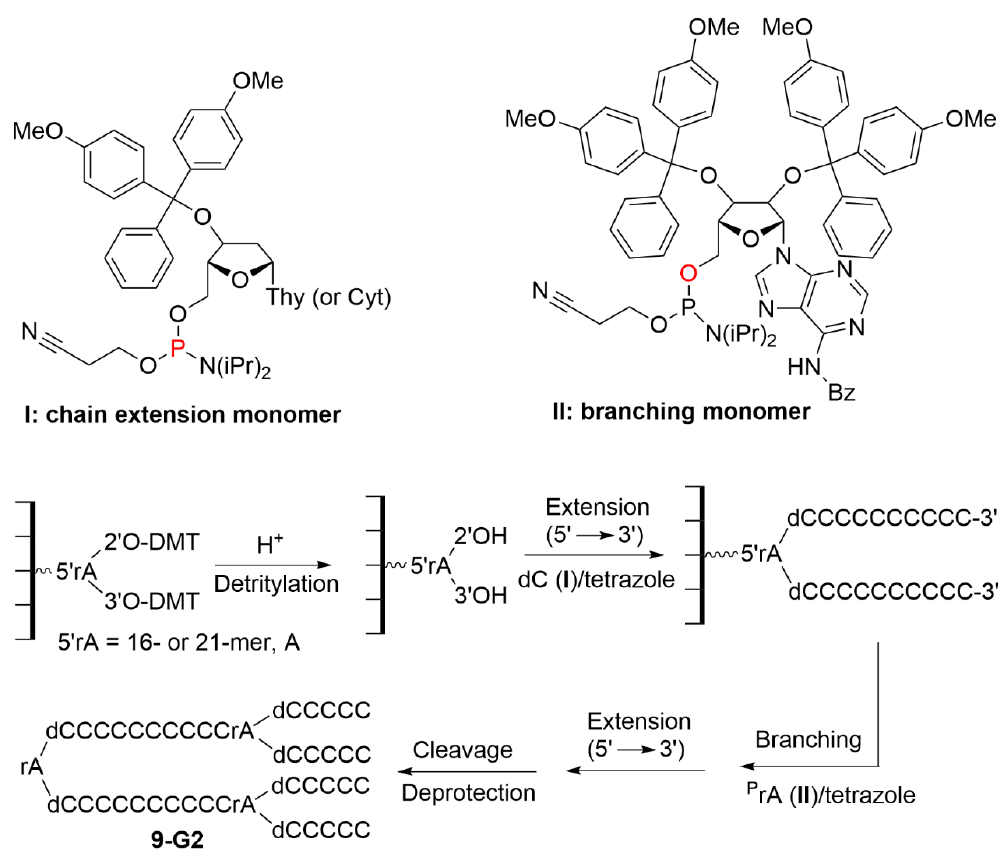
Scheme 9. Structure of phosphoramidite reagents used for chain extension ( I ) and branching ( II ), and the divergent synthesis of nucleic acid dendrimers 9-G2 , in the solid phase.